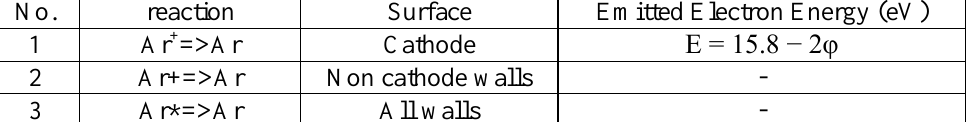
Table 2: The surfaces reactions used in simulation as following.